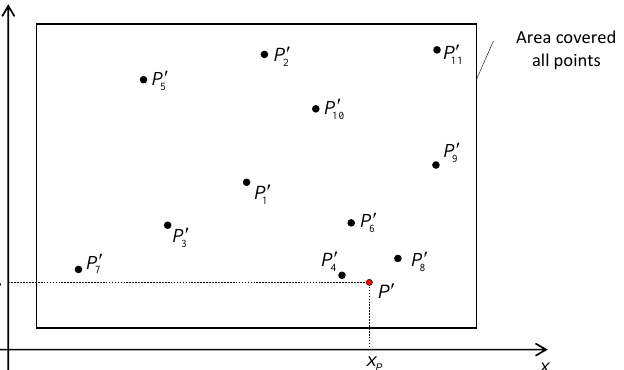
Figure 9. Some examples of the point distribution, 𝑃′ , are the point near which the point being its nearest “neighbor” is searched.